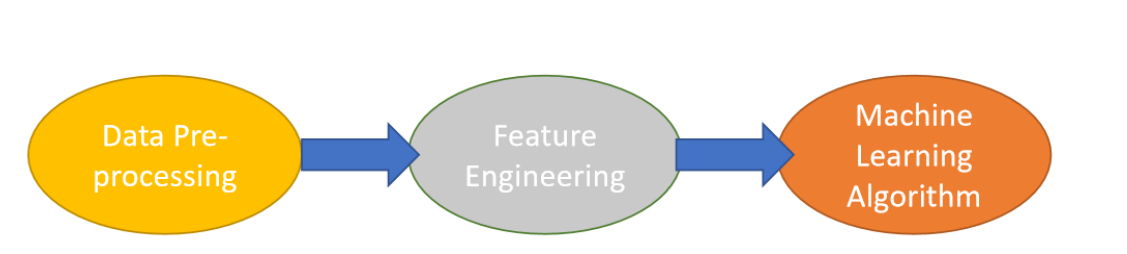
Figure 1. Proposed framework overview: non-invasive skin hydration level detection using machine